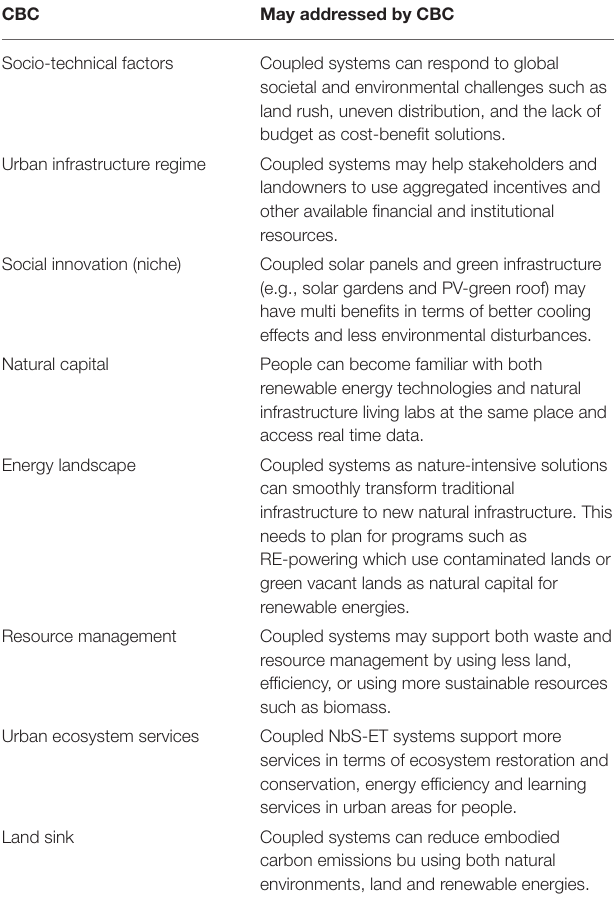
TABLE 2 | Synthesis of responsibility of coupled NbS-ET systems to each CBC’s